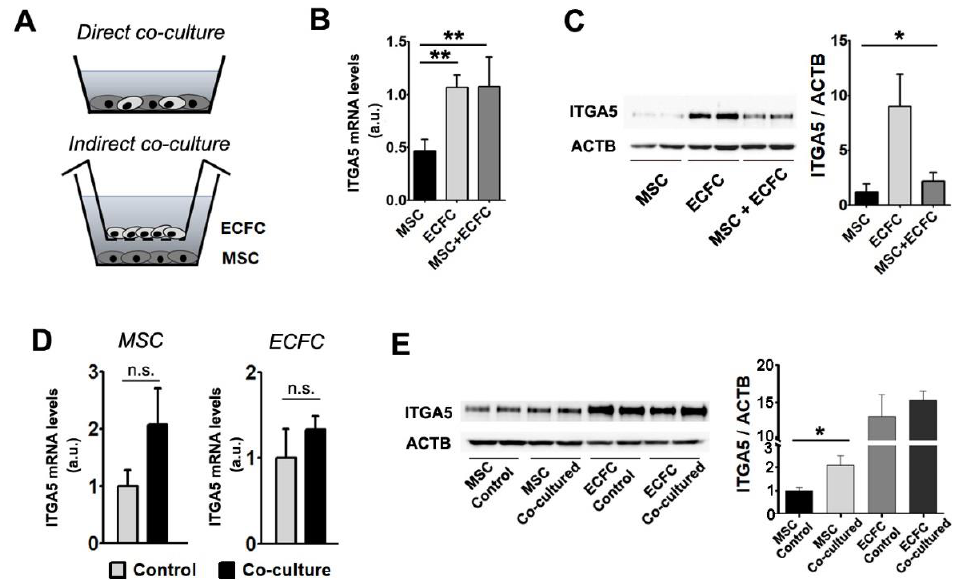
Figure 3. Gene and protein expression modulation following MSC + ECFC co-culture. ( A ) Schematics of the experimental settings used for MSC + ECFC direct contact (upper image) and indirect co-culture (lower image). ( B ) Gene expression analysis of ITGA5 in individual cultures and MSC + ECFC direct co-culture, indicating the induction after co-culture. ( C ) Western blot showing protein levels of Integrin alpha-5 subunit after direct MSC–ECFC interaction. ( D ) Gene expression analysis of ITGA5 in MSC (left side) and ECFC (right side), in individual cultures (control) and after indirect-contact co-culture. ( E ) Western blot showing ITGA5 protein level in MSC and ECFC following indirect contact co-culture. Data are mean ± SD. (Statistics: one-way ANOVA followed by Tukey’s multiple comparison test and two-tailed, paired t test; * p value < 0.05; ** p value < 0.01).